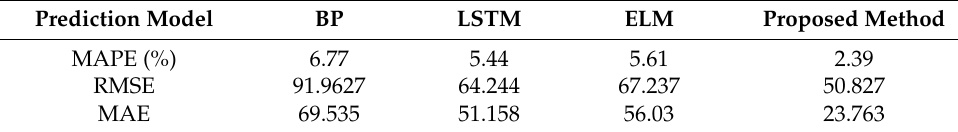
Figure 9. Load forecasting of different methods. Table 5. The error between different methods.